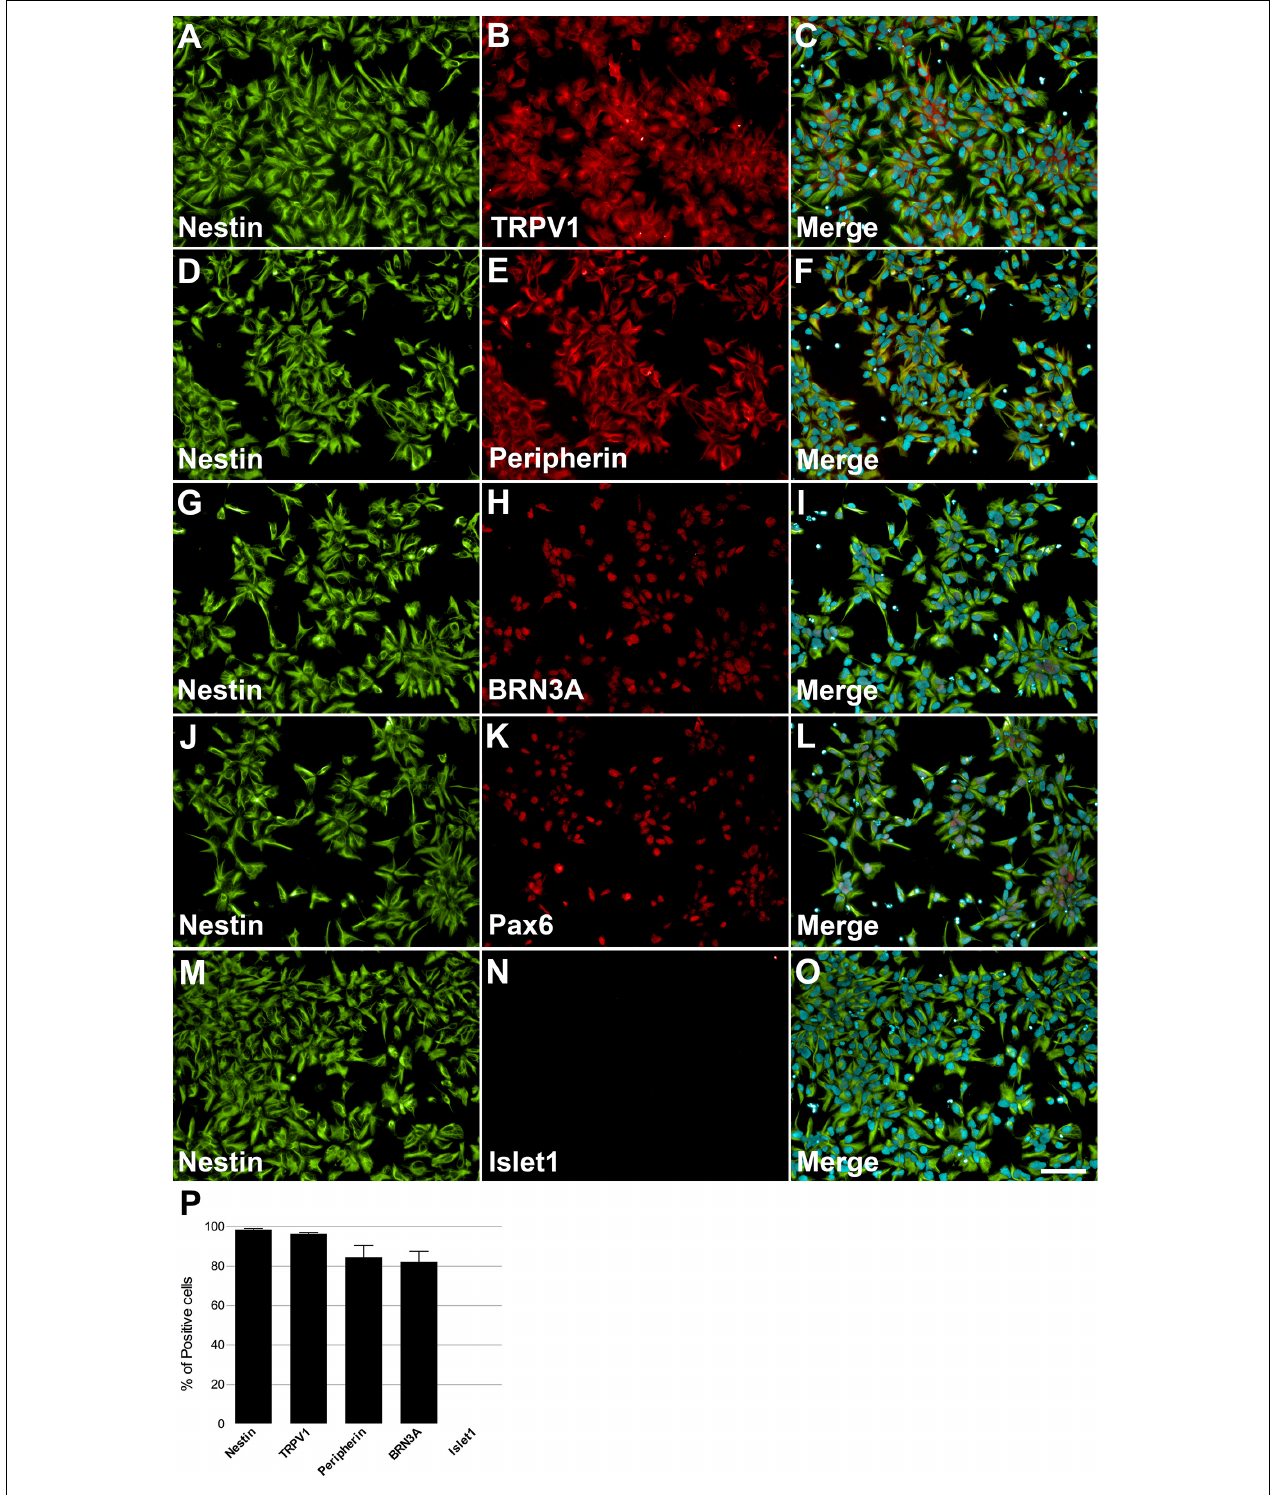
FIGURE 2 | Characterization of NCPCs with specific markers. On day 10, cells presented neural progenitor cell’s morphology and positive staining for Nestin (A,D,G,J,M) , TRPV1 (B) , Peripherin (E) , BRN3A (H) , Pax6 (K) , and negative for Islet1 (N) . Nuclei were stained with DAPI and superimposed with staining for nestin and TRPV1 (C) , Peripherin (F) , BRN3A (I) , Pax6 (L) , and Islet1 (O) . Calibration bar = 100 µ m. Quantification of positive cells for each marker relative to DAPI-stained nuclei, n = 2–3 independent experiments (P) .